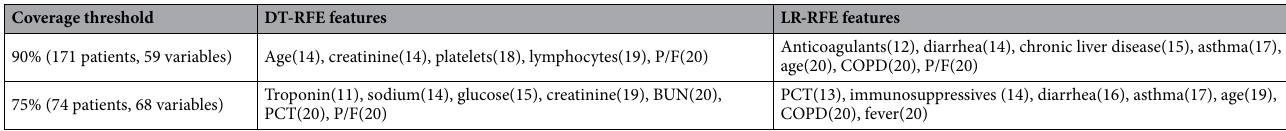
Table 2. Features selected by recursive feature optimisation (RFE) employing logistic regression (LR) and decision trees (DT). We show two different experiments, with different initial selection of starting clinical variables (coverage of 90% and 75% of patients). In parentheses we show the frequency with which the feature was selected, out of 20 validation runs (20-fold cross validation). A frequency of 20 means features were selected in all validation runs. We only include features selected in over 50% of the runs.